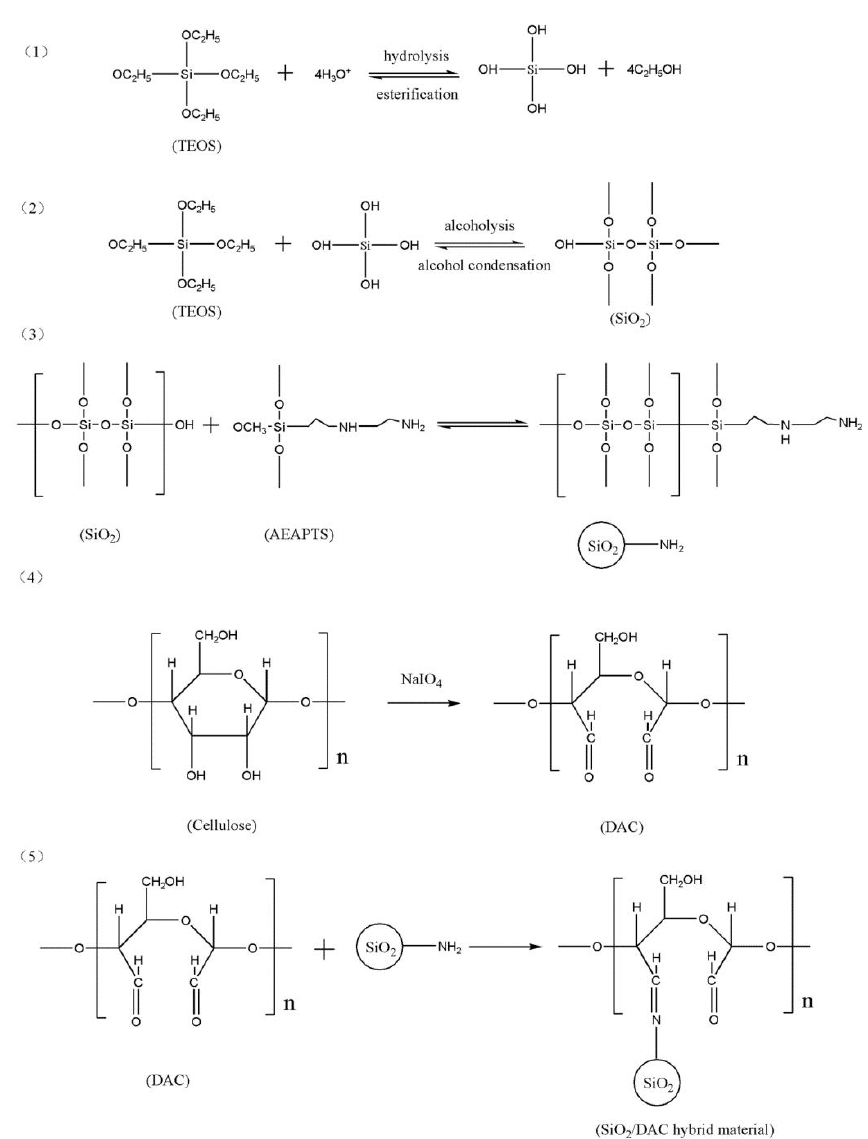
Scheme 1. Schematic illustration of the preparation of SiO 2 /DAC hybrid